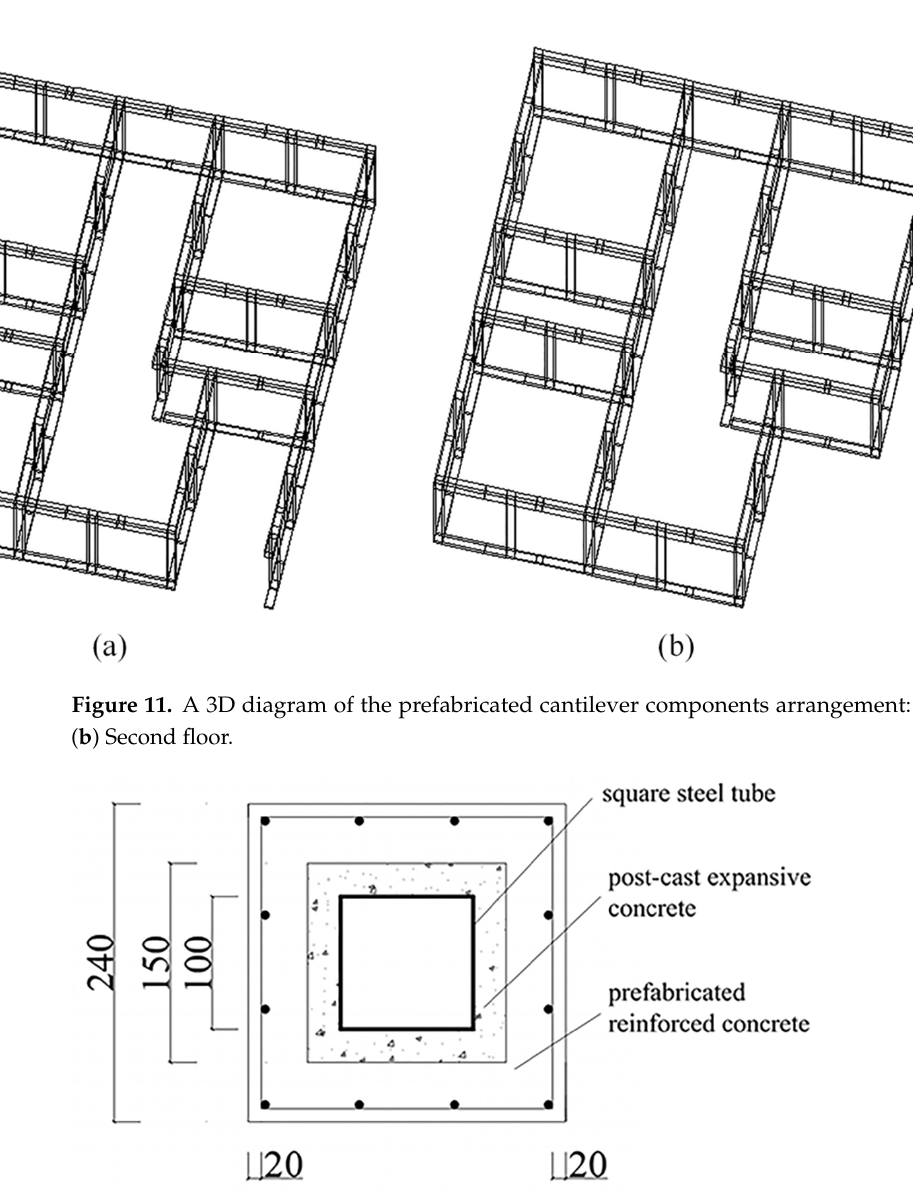
Figure 10. Positions and numbers of various types of prefabricated cantilever components: ( a ) first floor and ( b ) second floor.